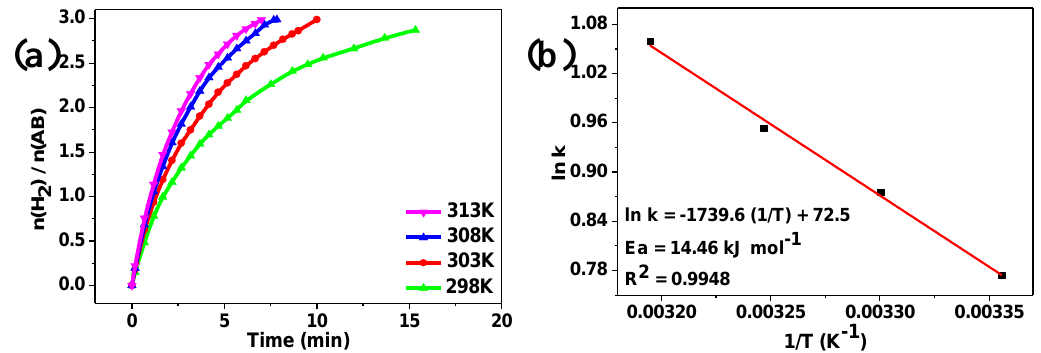
Figure 10. ( a ) Hydrogen evolution at di ff erent reaction temperatures in the range of 298–313 K; ( b ) the relationship between logarithm of k and 1 / T. Table 1. Comparison of the STY value and apparent activation energy of our Cu 0.4 Co 0.6 MoO 4 / g-C 3 N 4 catalyst with those of some other representative noble-metal-free catalysts in the literature.